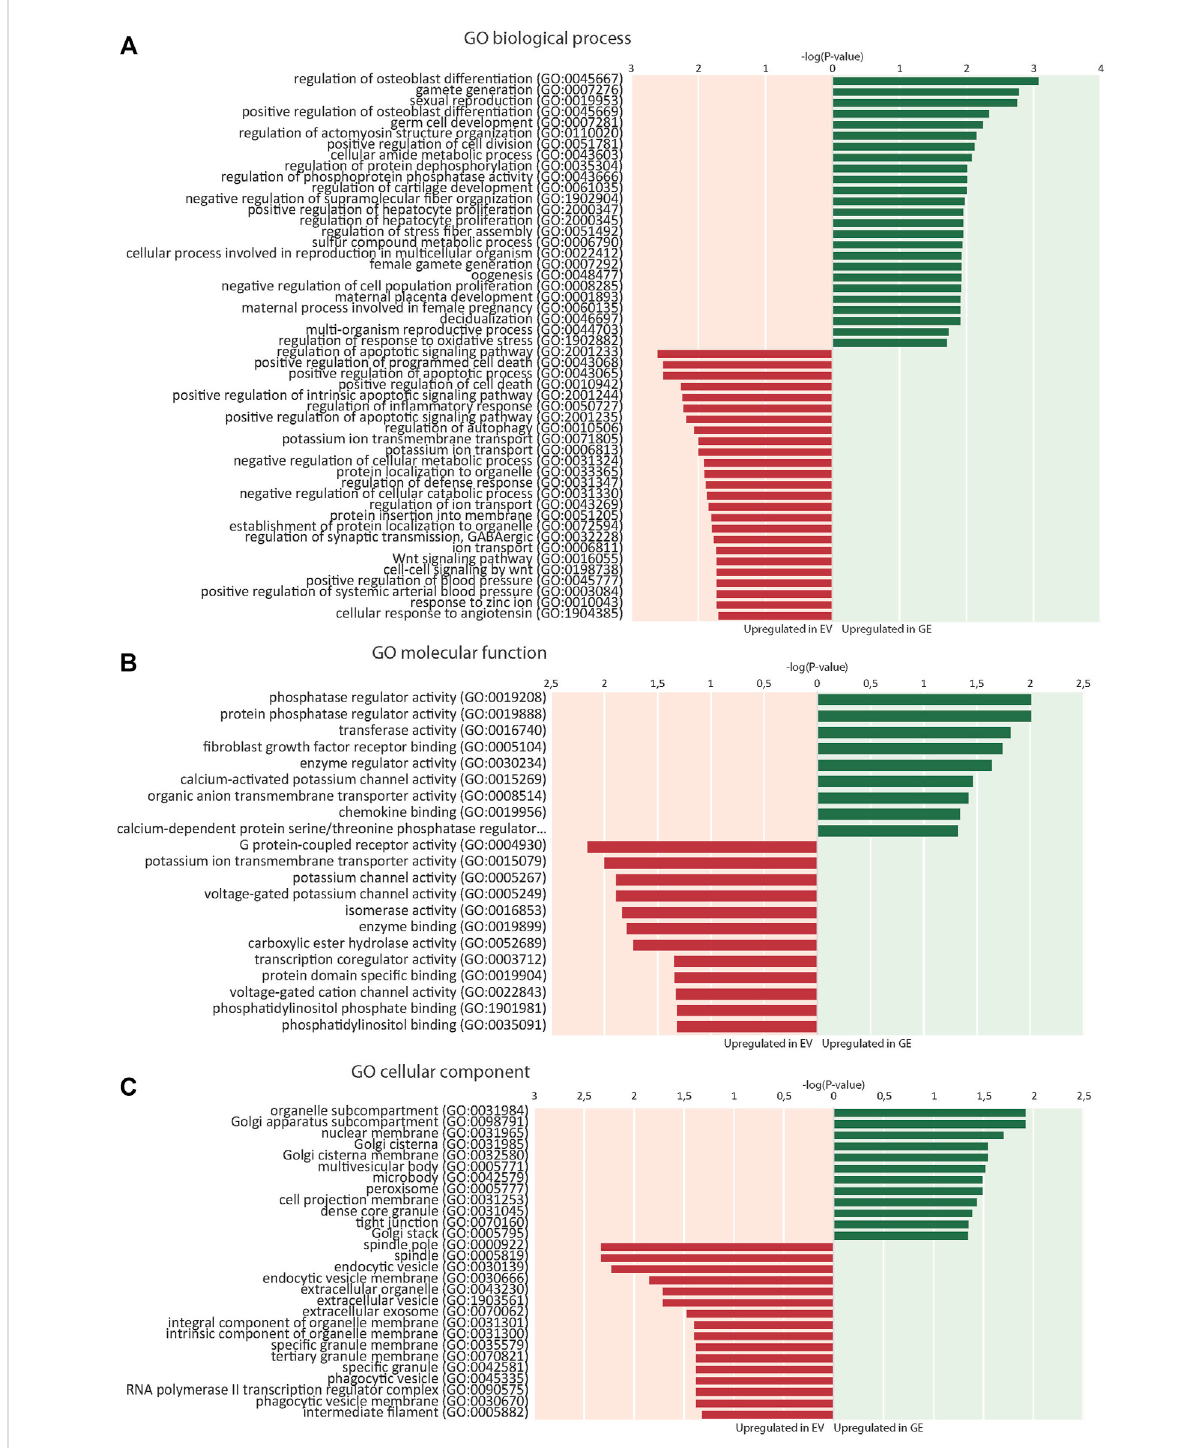
FIGURE 5 Enrichment ofgene ontology (GO) terms. (A) 25topdysregulated GO biological processes inEVand GE cells. (B) Signi fi cantly dysregulatedGO molecular functions. (C) Signi fi cantly dysregulated GO cellular components. Upregulated processes in GE cells are indicated in green. Upregulated processes in EV cells are indicated in red. GE: Gene edited with ARSB cDNA, EV: Gene edited with empty vector